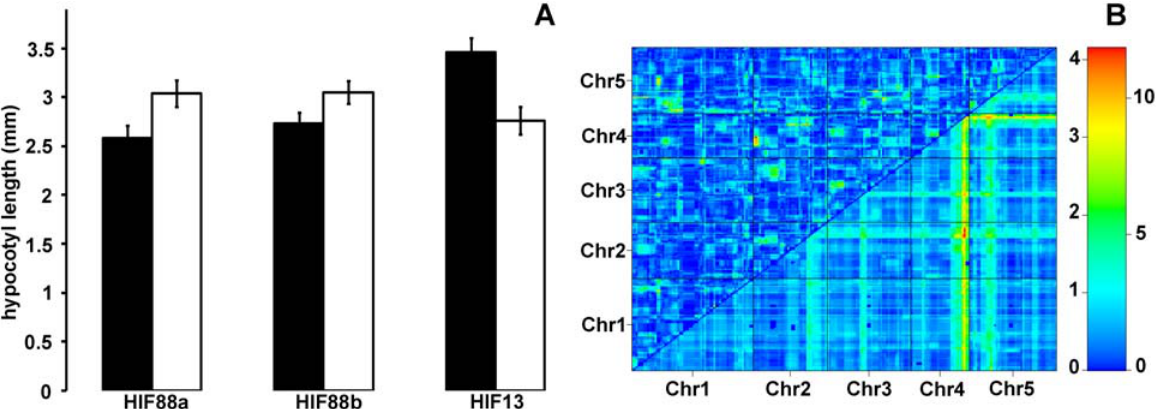
Figure 6. Confirmation of the chromosome 4 and 5 QTL for blue light response. (A) Comparison of hypocotyl lengths of heterogeneous inbred families segregating for the chromosome 4 (HIF88a and HIF88b) and 5 (HIF13) QTL. Col alleles are shown as black bars and Est-1 alleles as white bars. Error bars represent 95% confidence intervals. (B) A scantwo analysis of blue light hypocotyl lengths. Top triangle shows epistasis, bottom shows additive interactions. Color scale indicates LOD scores for epistasis (left) and additive interactions (right).